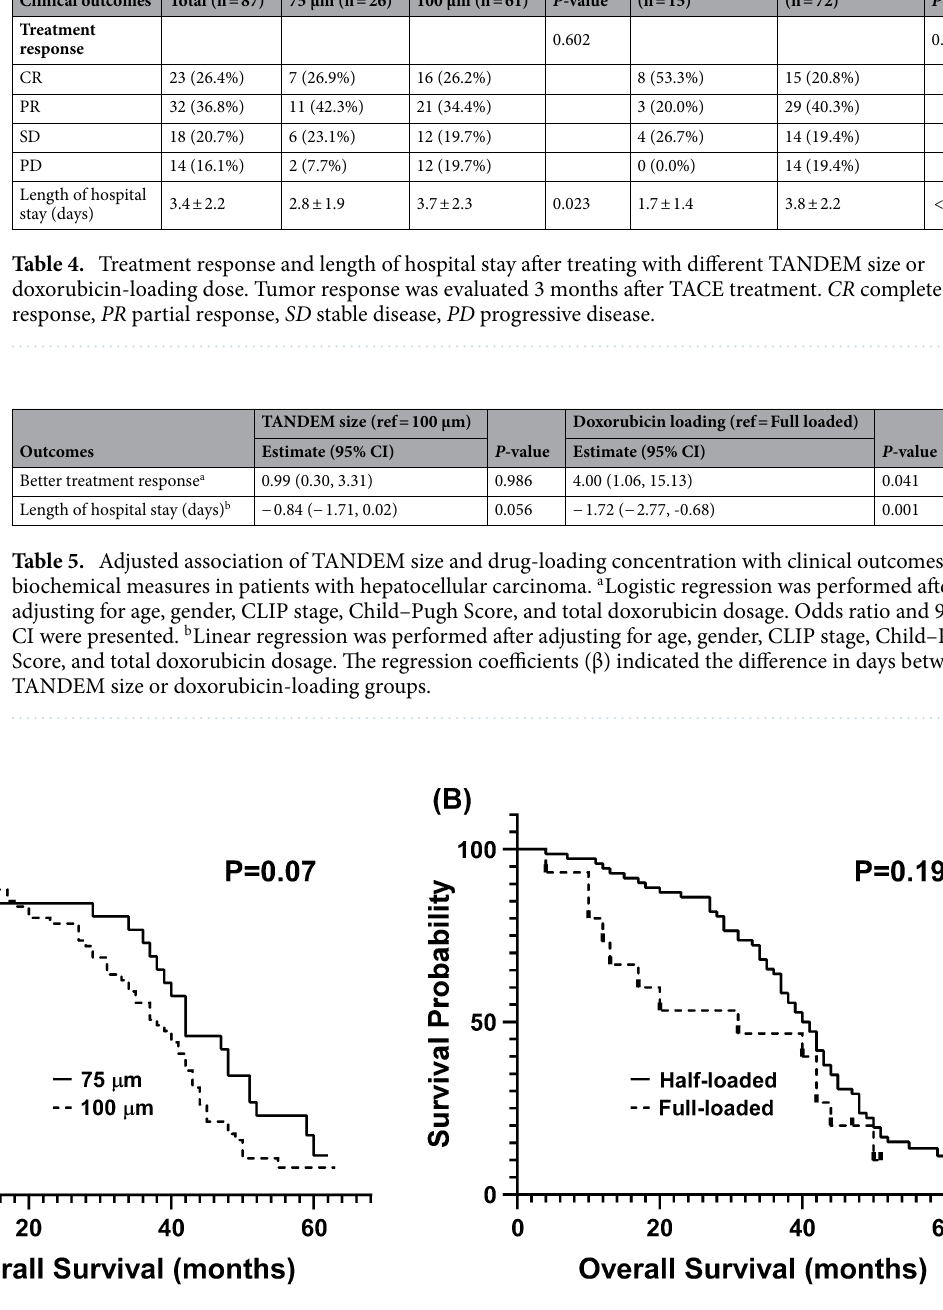
Figure 1. Kaplan–Meier survival curve of hepatocellular carcinoma patients who underwent DEB-TACE with ( A ) 75-µm or 100-µm microspheres or ( B ) with half-load or full-load doxorubicin